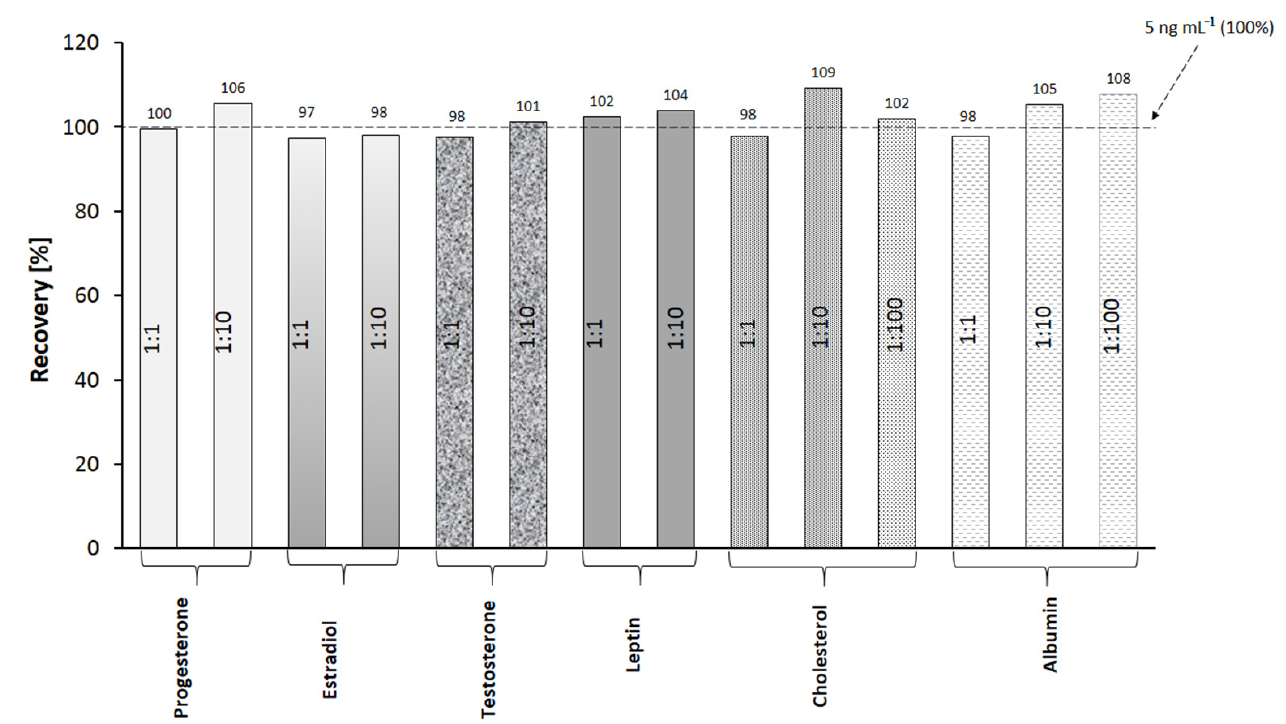
Figure 3. Specificity of cortisol determination. Determinations of cortisol (5 ng mL − 1 ) in the presence of variable excesses of potential interferents.